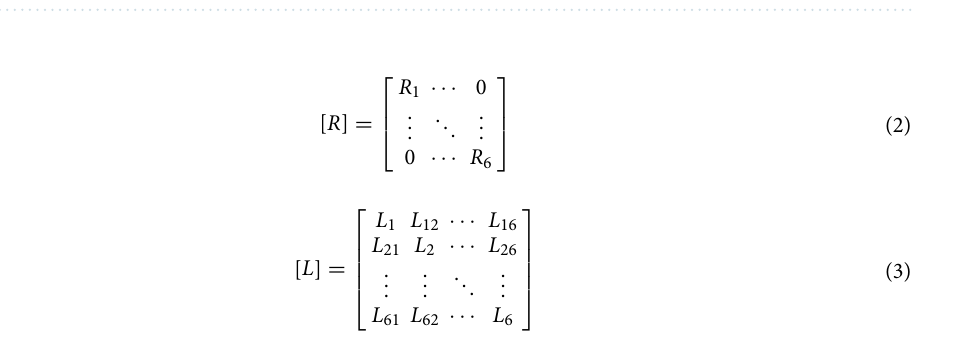
Figure 3. Diagram of two-winding transformer showing the effects of stray capacitances 36